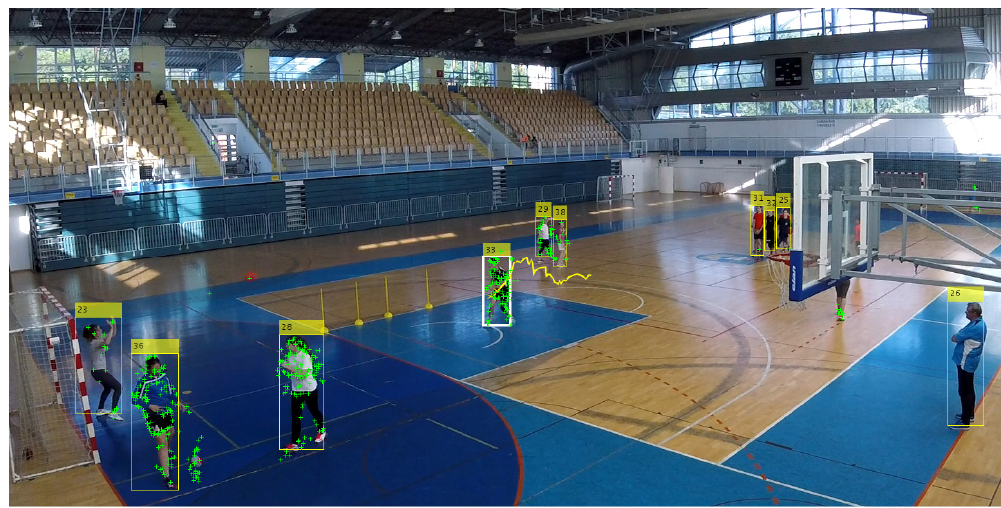
Figure 8. Detected most active player (white thick bounding box) and his trajectory through the whole sequence (yellow line).